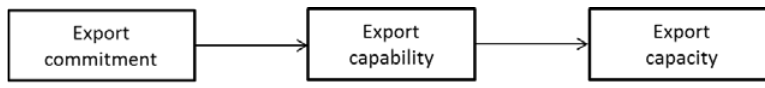
FIGURE 1: Conceptual